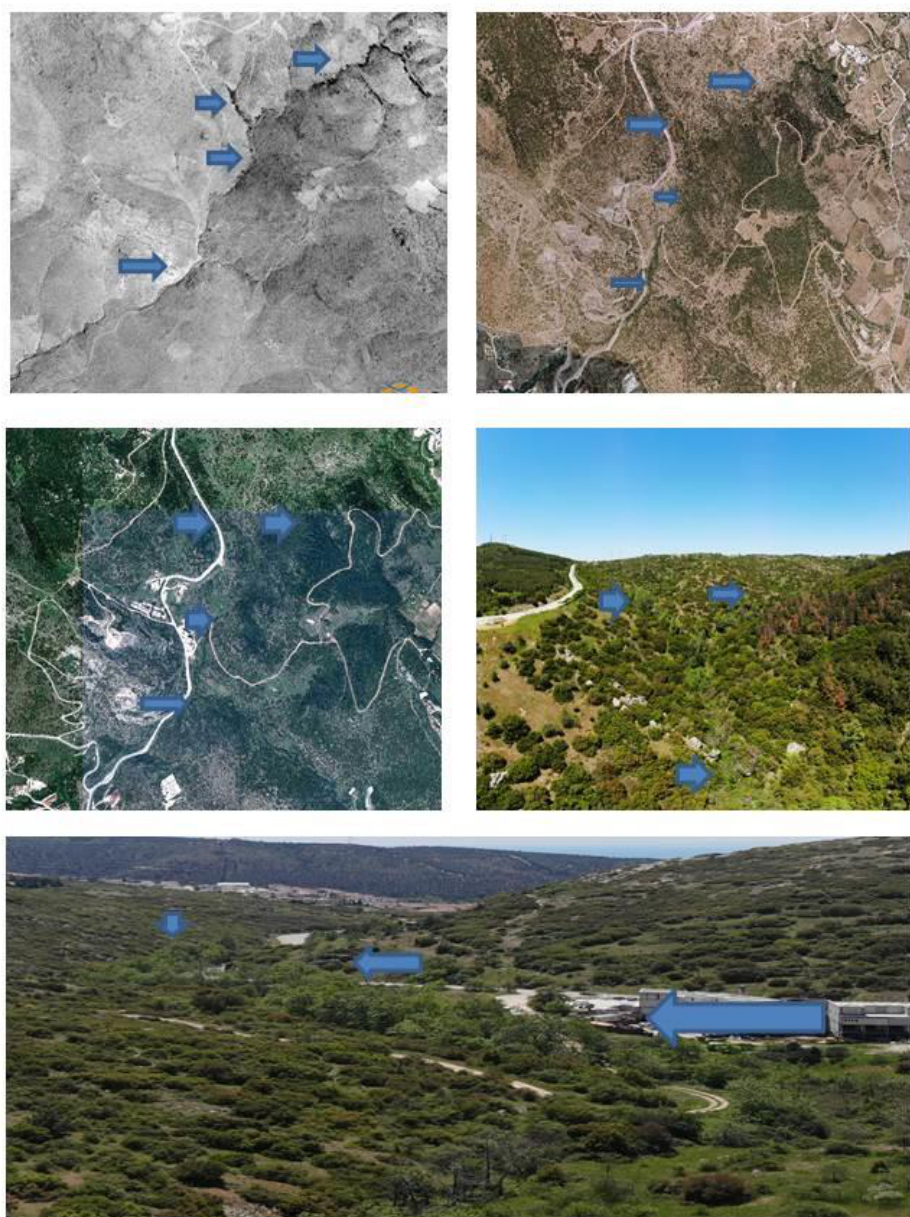
Figure 8. Afforestation of the part of Dendropotamos crossing pastures. From top left to bottom: aerial photos of 1945–1960, 2007–2009, 2015–2016, and 2021. Blue arrows are pointing at the riparian area.